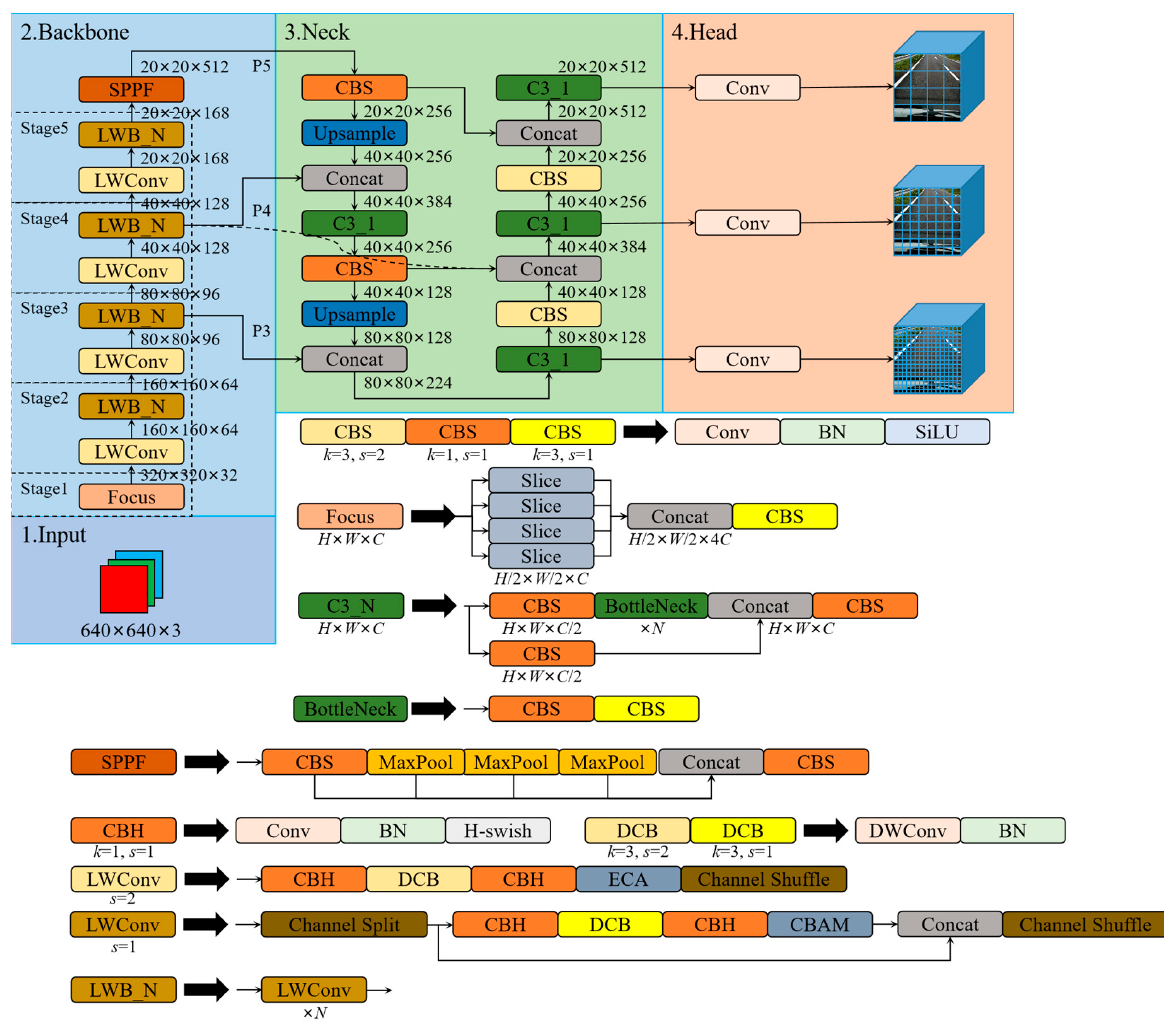
Figure 4. The network structure of the YOLO-LWNet-Small. Where, LWConv ( s set to one) is the basic unit in the LWC module, and LWConv ( s set to two) is the unit for spatial downsampling in the LWC module. In LWConv ( s set to one), the CBAM attention module is used as attention. The ECA attention module is used as attention in LWConv ( s set to two). In the small version, the hyperparameter N of LWblock (LWB) in stage two, three, four, and five in the backbone is set as one, four, four, and three, respectively.